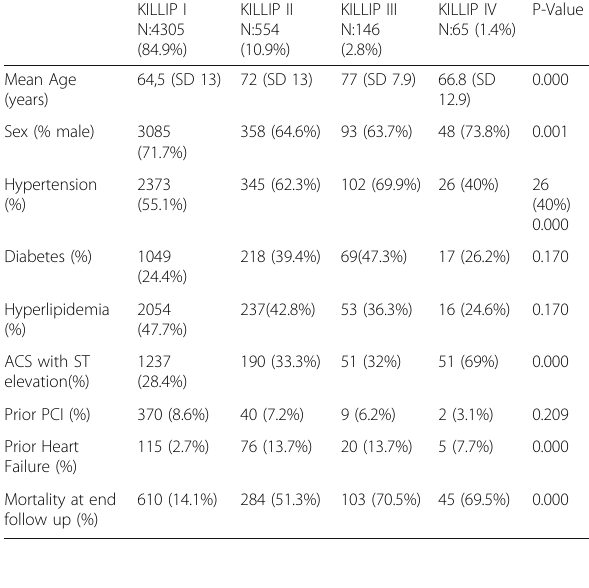
Table 68 (abstract A195). Characteristics by Killip Class